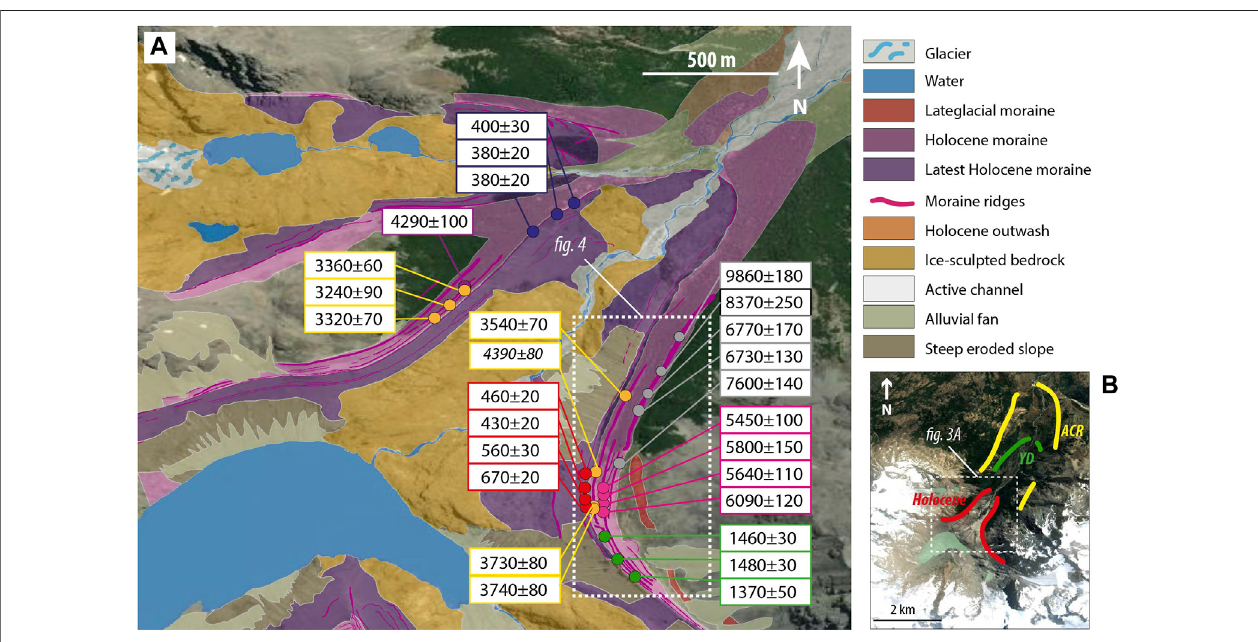
FIGURE 3 | (A) Glacial geomorphologic map of the Río Tranquilo valley with new 10 Be ages. Circles with the same color correspond to samples on the same moraine ridge or on correlated ridges on opposite sides of the valley. Individual 10 Be ages are provided with 1 σ analytical uncertainty (Table 2) . One outlier is shown in italics. (B) Relative position of the Antarctic Cold Reversal (RT1-4 margins), Younger Dryas (RT5 margin) and Holocene margins (RT6) (Sagredo et al.